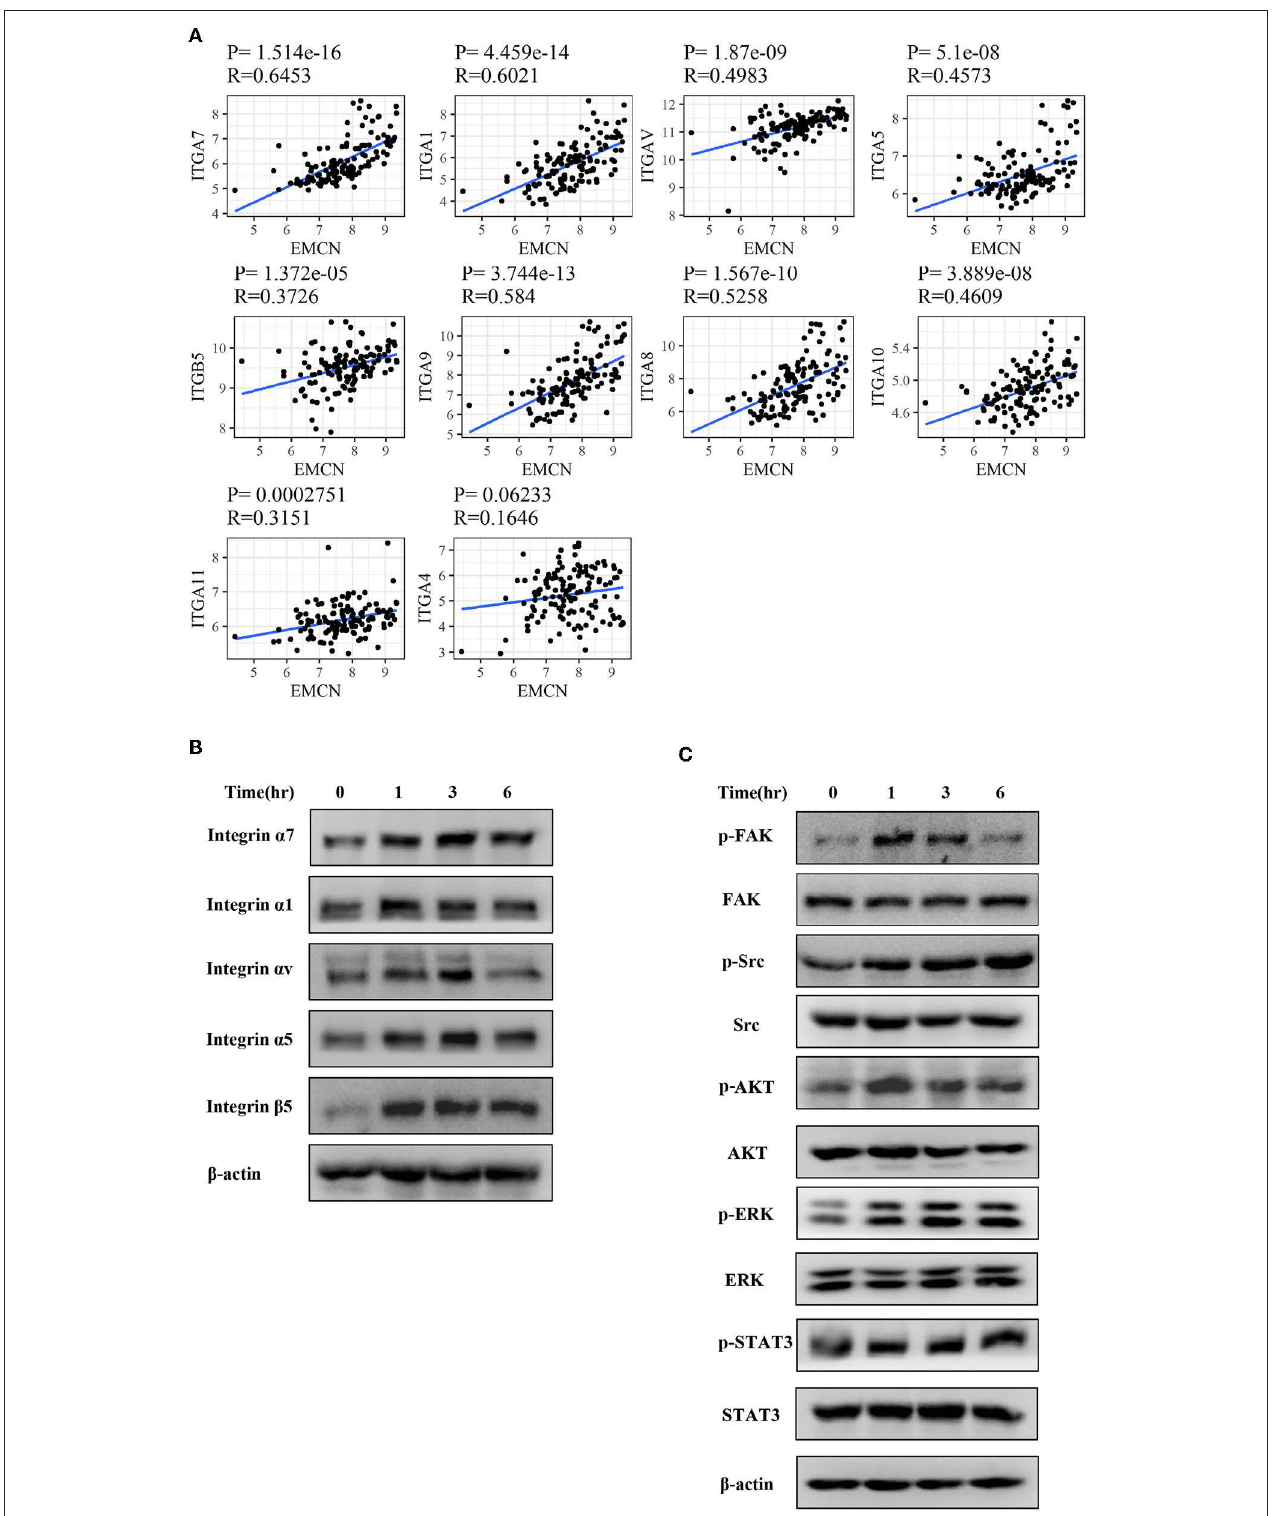
FIGURE 8 | EMCN activated integrin-FAK pathway. The correlation between the expression of integrin family members and EMCN was analyzed using GSE62254 dataset (A) . Expression change of integrin family members, integrin α 1, α 5, α 7, α v, and β 5 induced by EMCN (100ng/ml) was detected by western blot in MKN45 cells. β -actin was used as internal control (B) . After MKN45 cells were treated with EMCN, the expression of p-FAK, FAK, p-Src, Src, p-AKT, AKT, p-ERK ERK, p-STAT3, and STAT3 were detected by western blot. β -actin was used as internal control (C) .